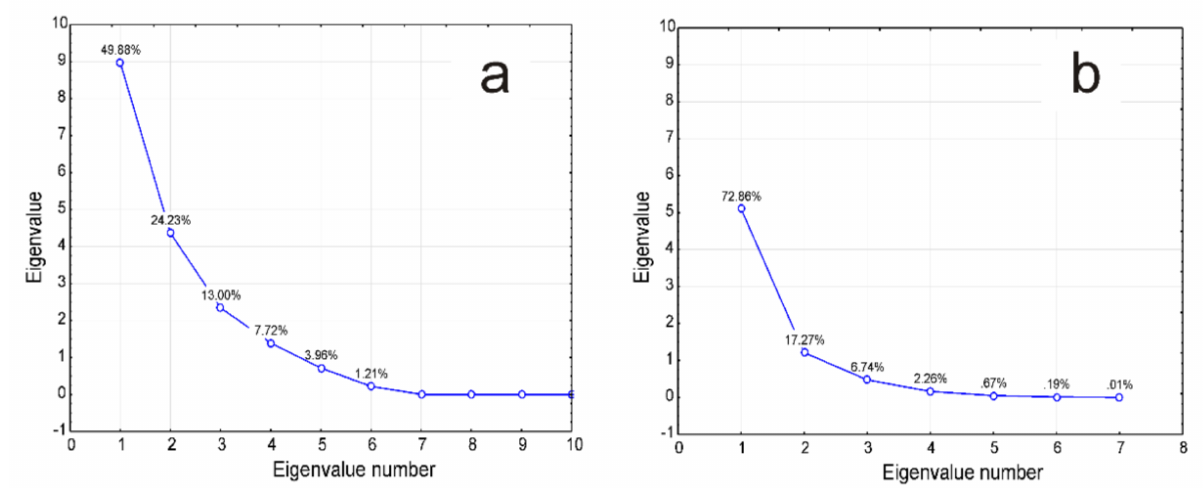
Figure 3. The scree plots of the Q ( a )- and R ( b )-mode